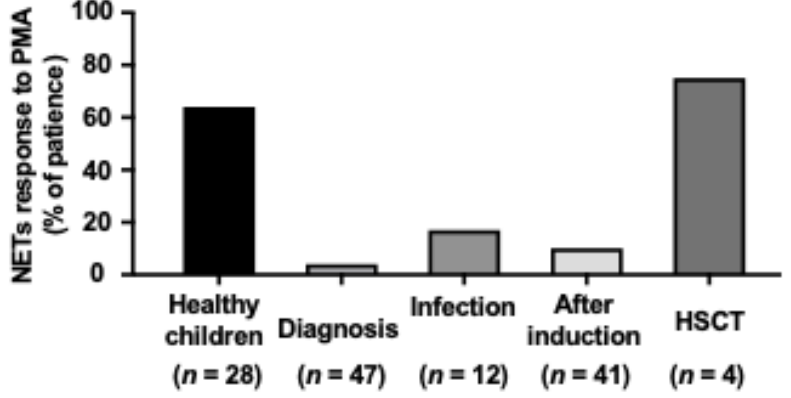
Figure 4. NETs release changes dynamically during the treatment of acute leukemia. Percentage of patient samples responding to PMA induction in vitro defined as at least 2-fold increase in extracellular DNA fluorescence (NETs release) observed 60 min after the addition of the inducer in comparison to the baseline. Number of patients in each subgroup is shown below respective bar.